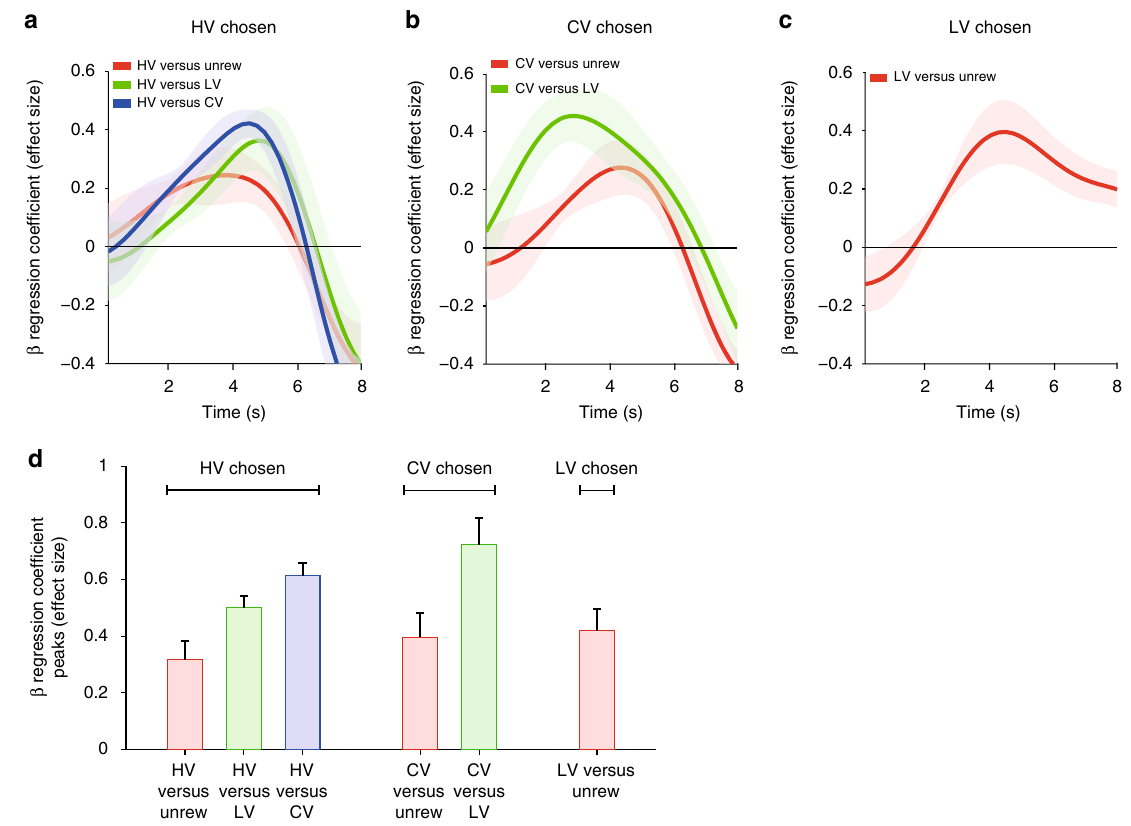
Fig. 4 Choice-based analysis of vmPFC activity — experiment 2. Time courses of vmPFC activity when HV, CV, LV, and unrewarded options are present (ROI from Fig. 3d). These are the four options whose values are illustrated in Fig. 3c (left panel). Because the impact that the option has on vmPFC activity changes depending on what other option is presented on any given trial (and therefore which option is likely to be taken and which is likely to be rejected) the time courses have been sorted by the value of the chosen option: HV a , CV b , or LV c . The effect of the value of the unchosen option can, for example, be seen in a : activity associated with choosing HV is greater when decisions are dif fi cult and choices are made between it and CV (blue) as opposed to LV (green) or Unrewarded (red). The effect of the chosen value can be seen by comparing either the red lines or the green lines in a and b : activity associated with choosing an option increases when it is harder to make the choice because its value is lower. Although a – c show the time courses of the effects of the various options on vmPFC activity, d illustrates the same information but using the peaks of the time